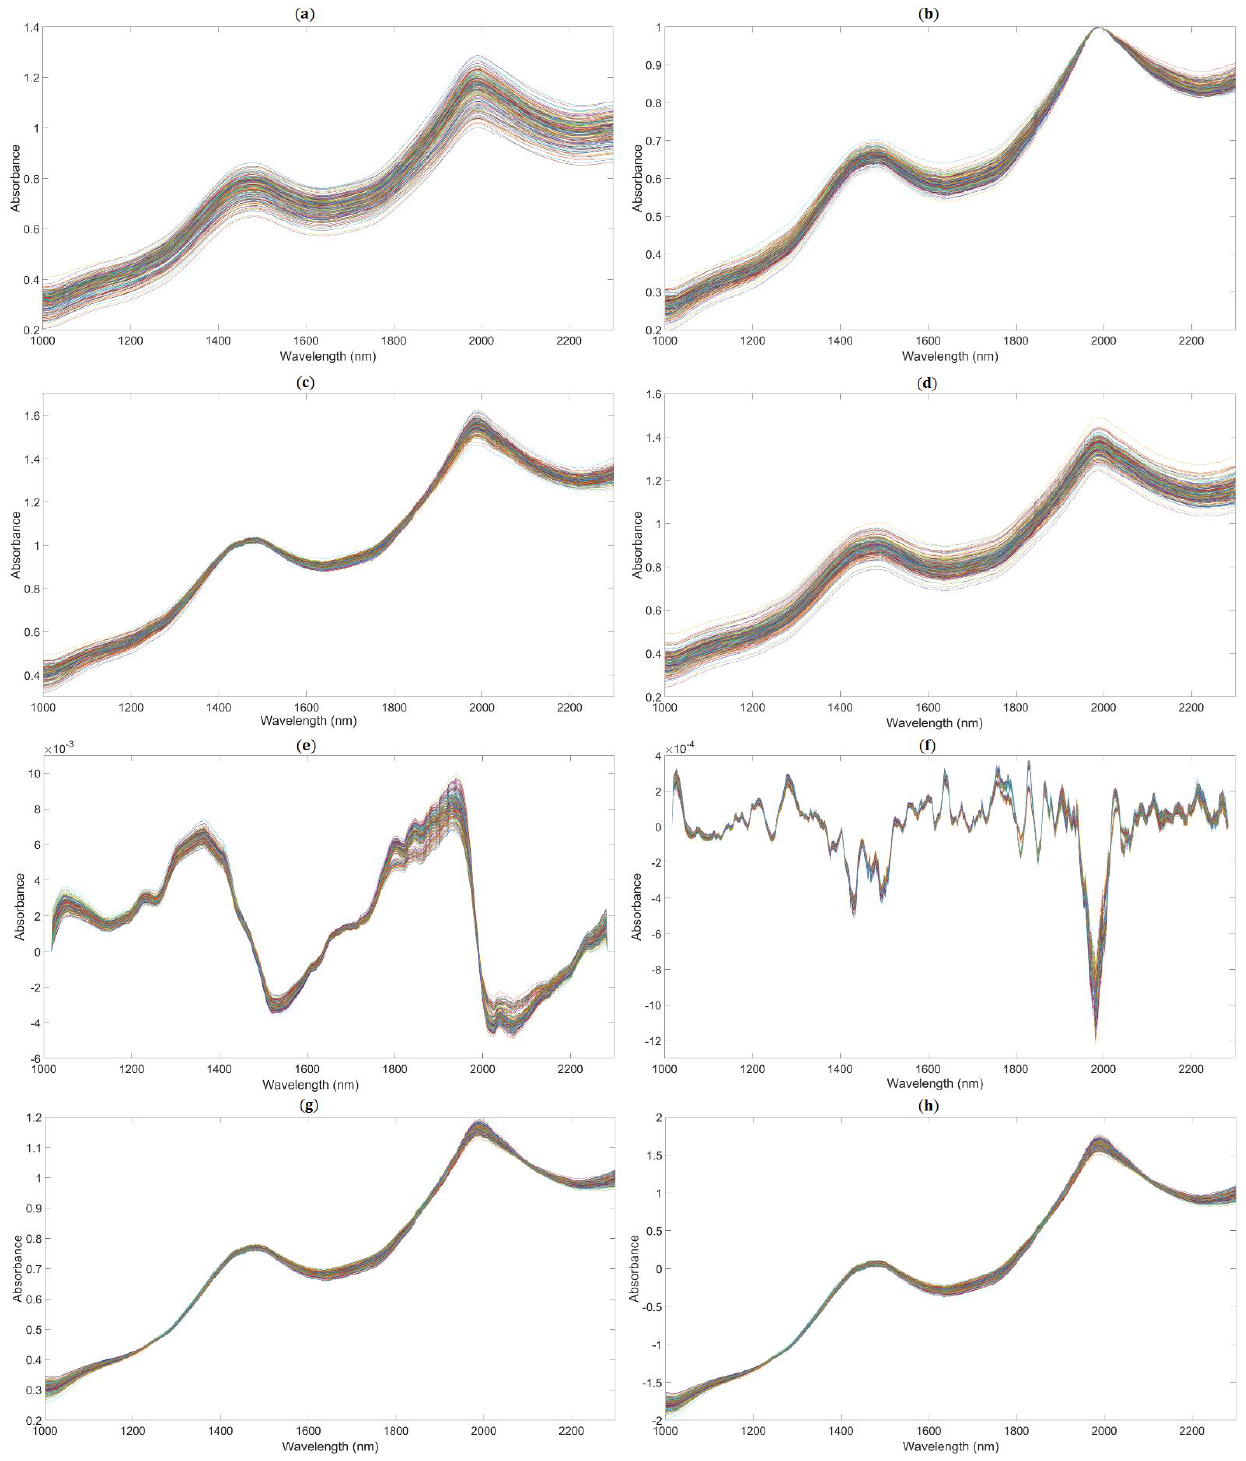
Figure 5. The NIR diffuse reflection spectra preprocessed by different methods. (The lines in figures are the absorbance values of 195 samples after pretreatment at the different wavelengths.). ( a ) Raw spectra by moving average smoothing (MAS). ( b ) Raw spectra by maximum normalization (MaxNorm). ( c ) Raw spectra by mean normalization (MeaNorm). ( d ). Raw spectra by range normalization (RanNorm). ( e ) Raw spectra by Savitzky – Golay first derivative (SG-D1). ( f ) Raw spectra by Savitzky – Golay second derivative (SG-D2). ( g ) Raw spectra by multiplicative scatter correction (MSC). ( h ) Raw spectra by standard normal variate (SNV).